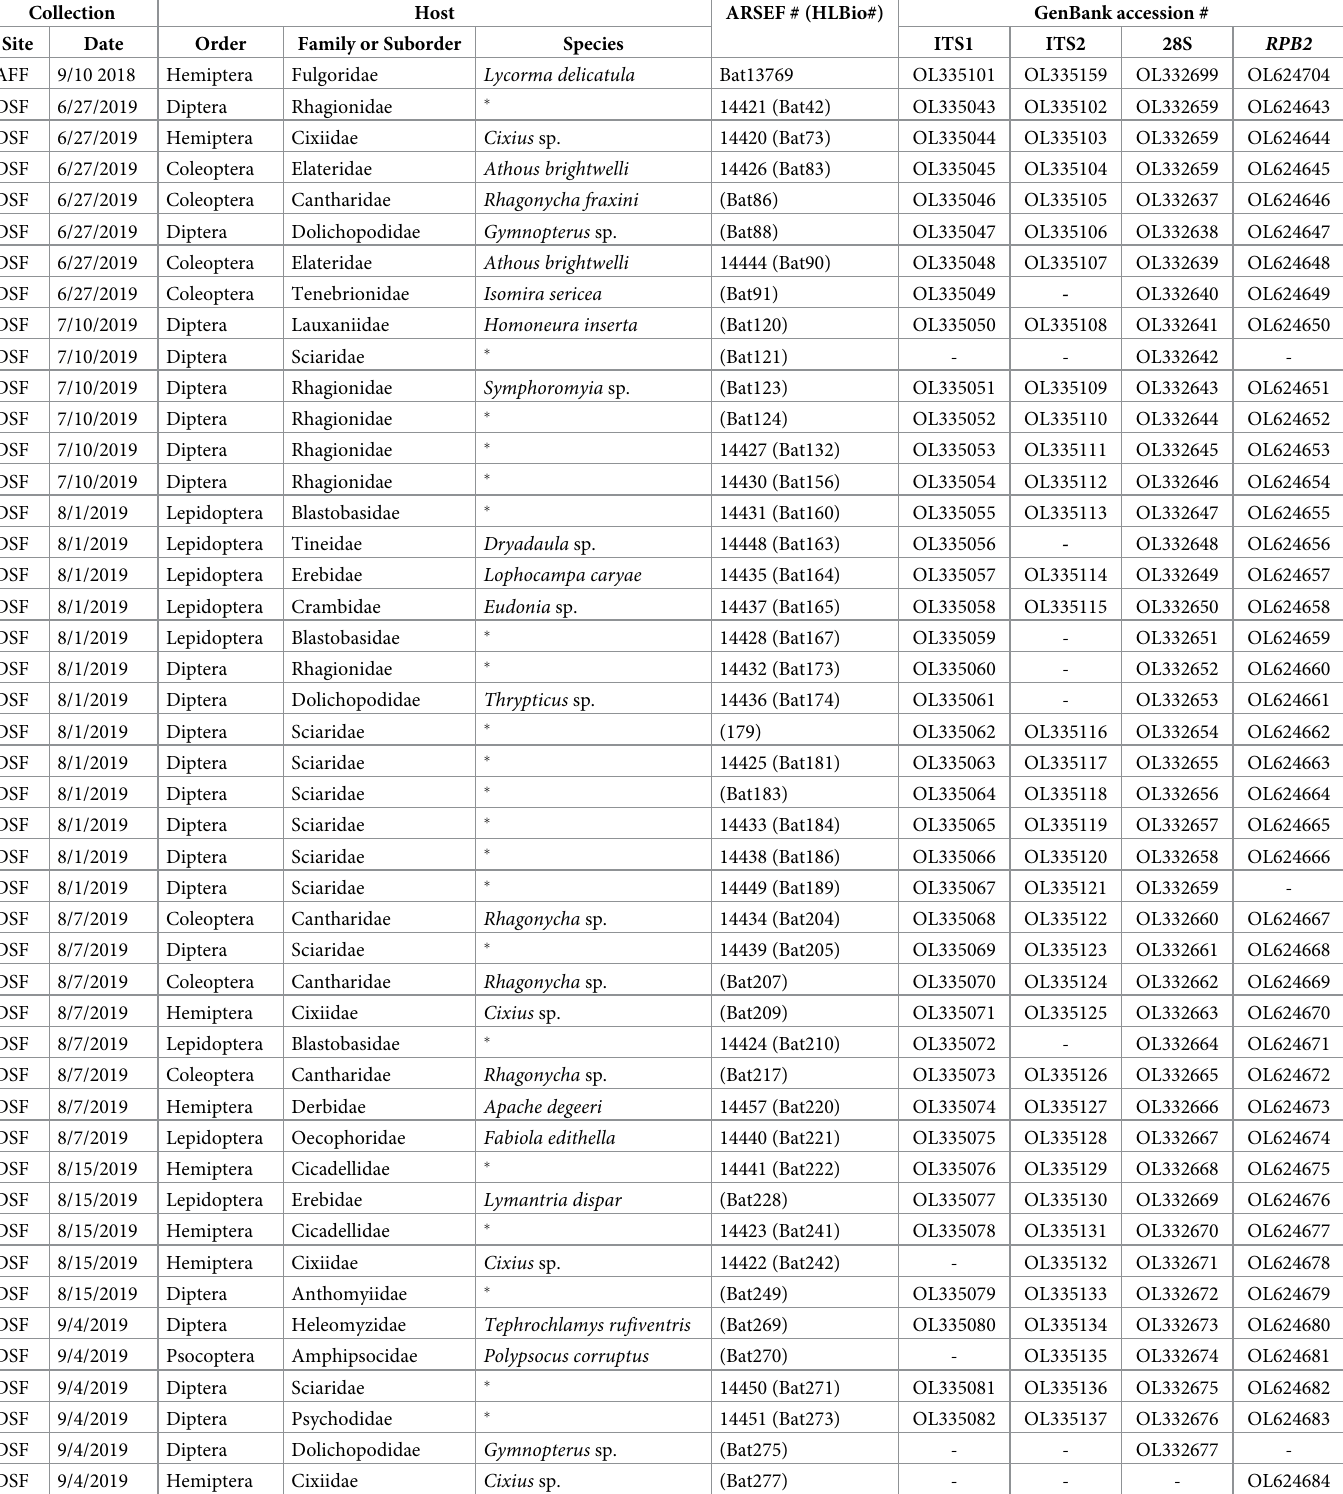
Table 1. Insect hosts collected in Pennsylvania and New York State, infected by Batkoa major in 2019–2020 (S1